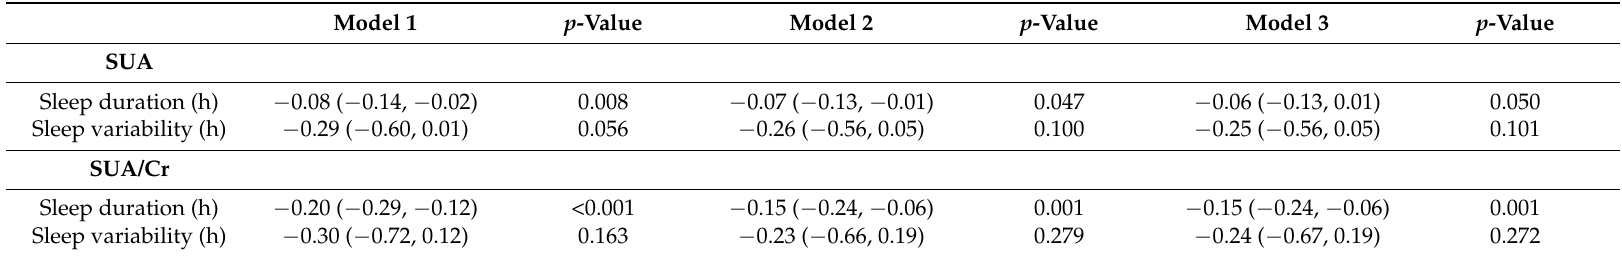
Table 3. β -coefficients (95% Confidence Interval (CI)) for association between serum uric acid, serum uric acid to creatinine ratio, and sleep measures (sleep duration, sleep variability